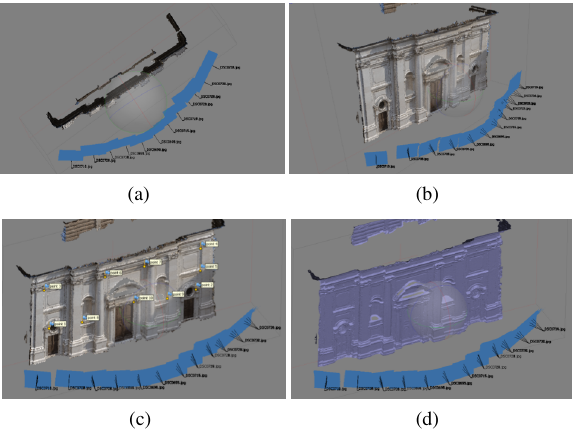
Figure 1. Sequence of steps performed to achieve the orientation and scaling of the 3D